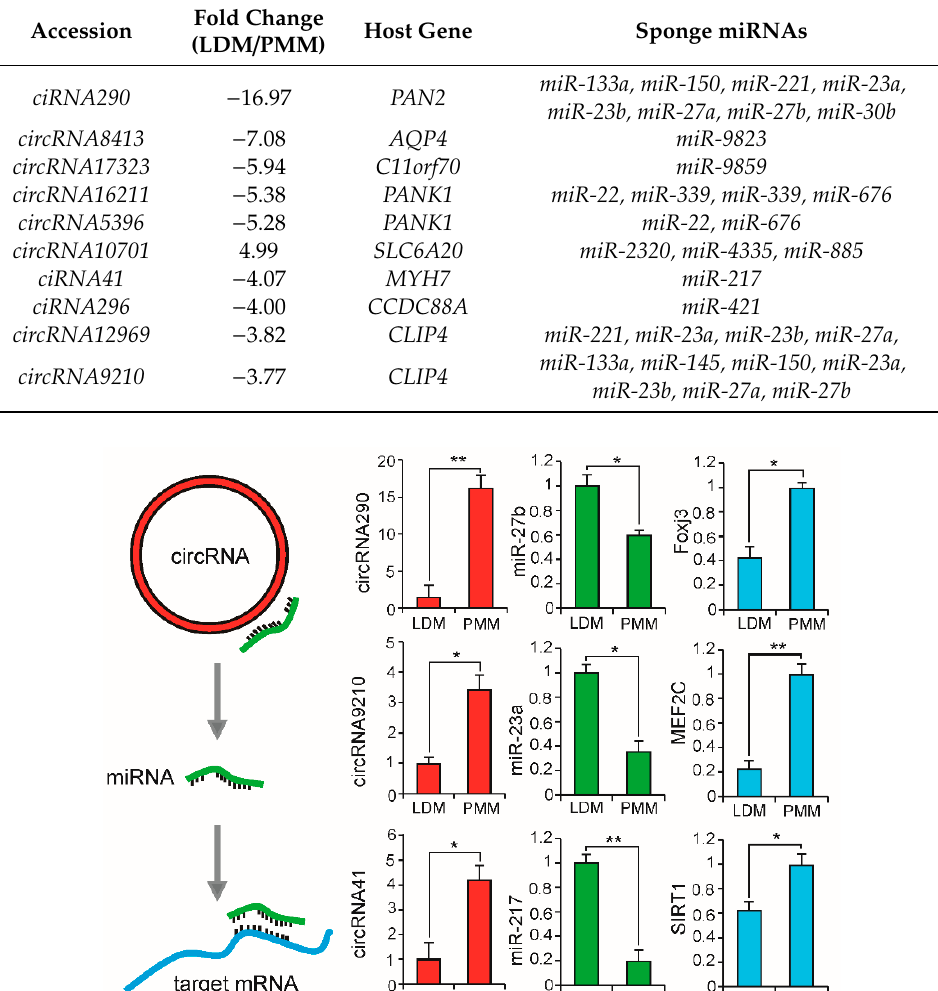
Table 2. The top ten di ff erentially expressed circRNAs between LDM and PMM.